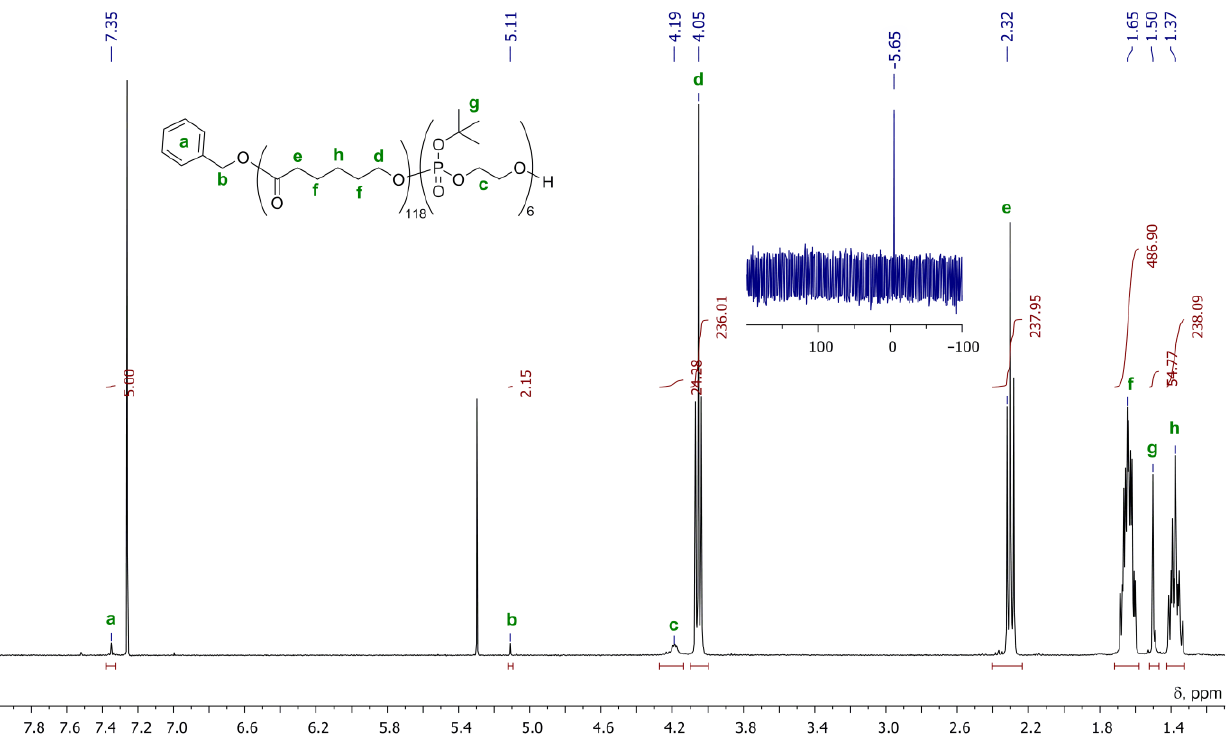
Figure 4. 1 H (black line) and 31 P (blue line) NMR spectra of BnO- (εCL) 118 - b -( t BuOEP) 6 recorded in CDCl 3 at 20 °C.